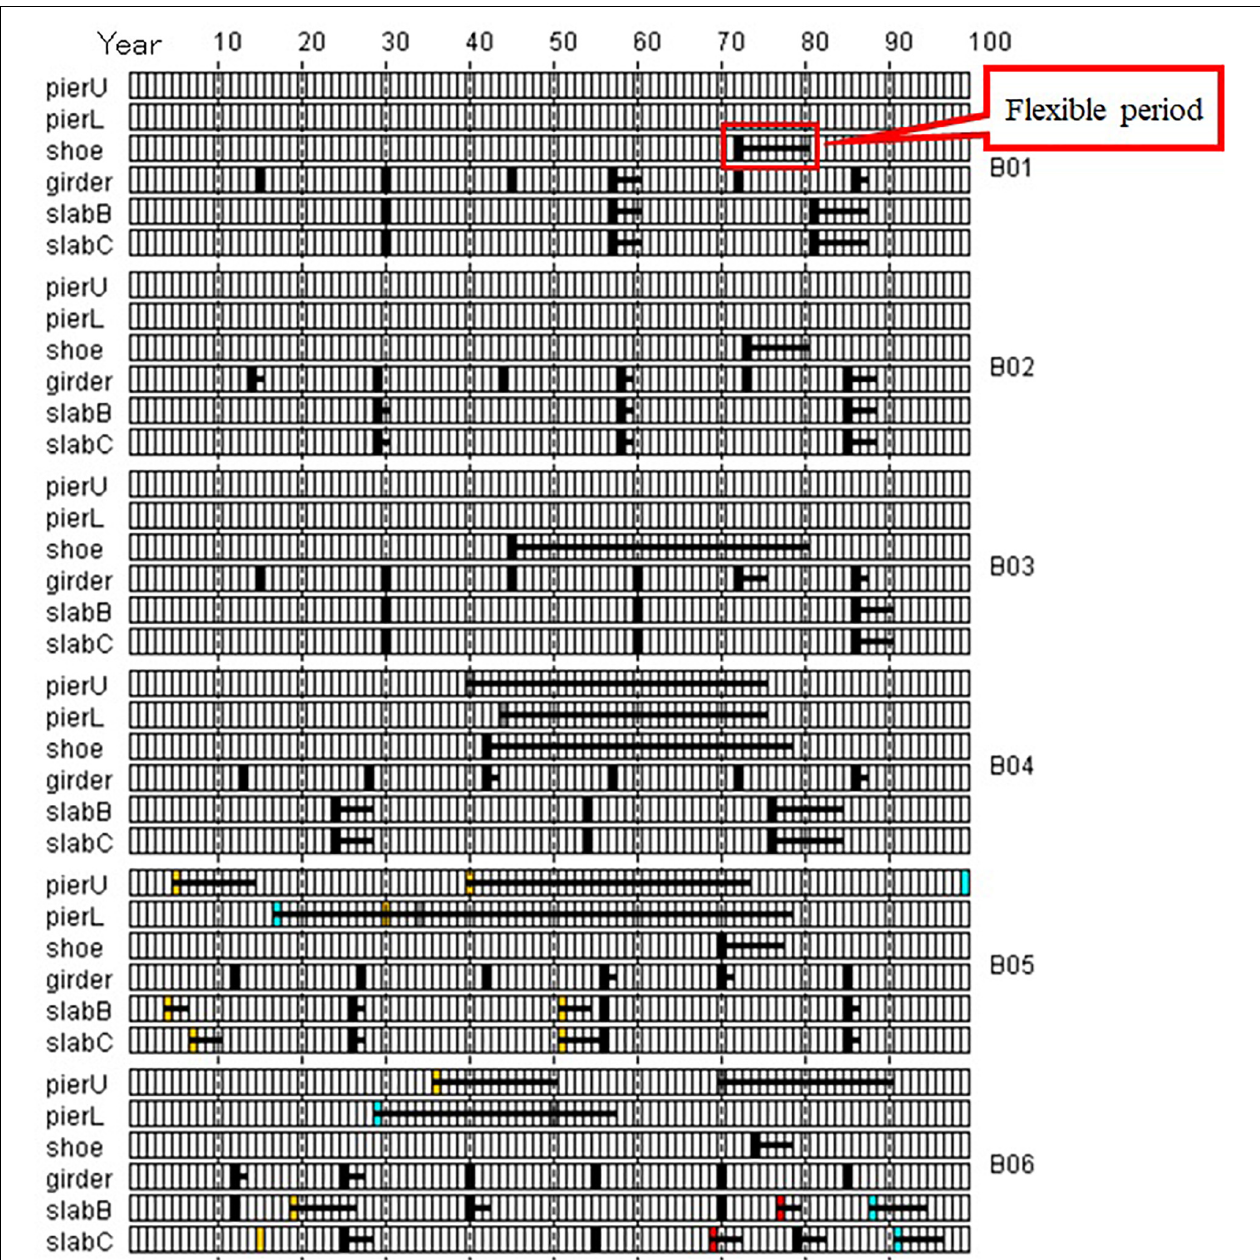
FIGURE 10 | Part of schedule with minimized construction